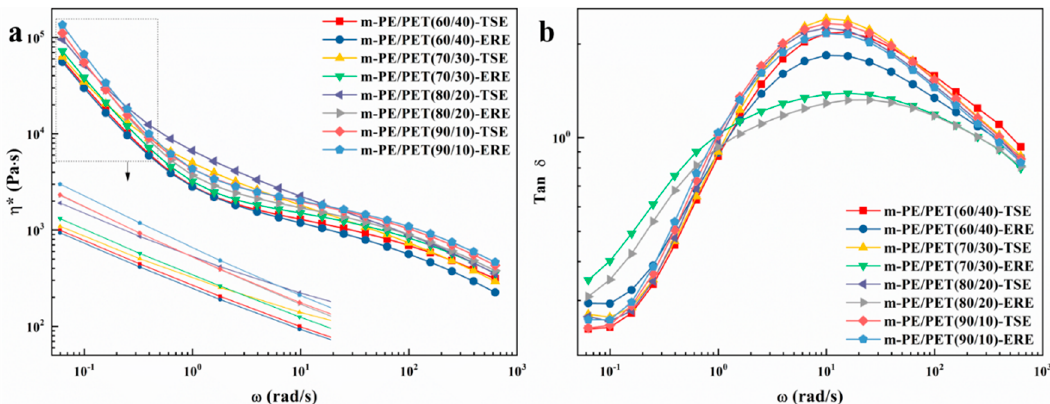
Figure 8. Dynamic rheology properties of m-PE / PET blends processed using ERE and TSE, respectively. ( a ) the complex viscosity of the blends processed by ERE and TSE; ( b ) the loss factor Tan δ of the blends processed by ERE and TSE.